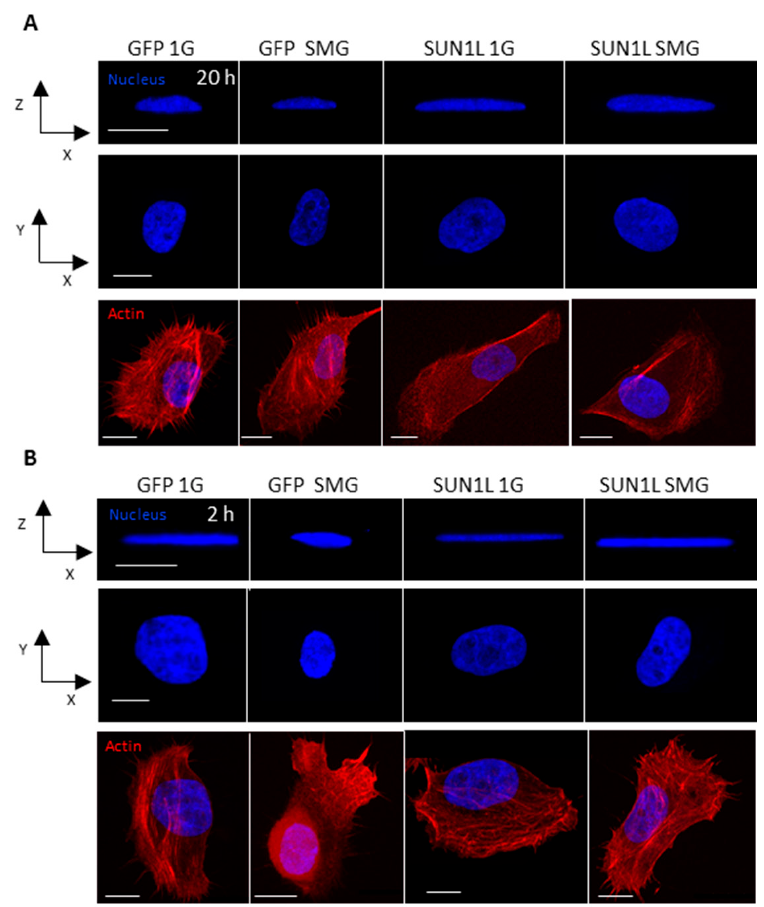
Figure 1. Nuclear shape response to simulated microgravity (SMG) depends on the LINC complex. ( A ) Confocal images show the nuclei (blue) and actin (red) staining (to reveal the cell morphology) of fixed GFP-KDEL (GFP) and SUN1L-KDEL (SUN1L) cells after 20 h in 1G and SMG. Top row shows the x-z view and the bottom rows show the x-y view of the corresponding nuclei and cells. Similarly, ( B ) shows confocal images of the nuclei and actin of fixed GFP-KDEL and SUN1L-KDEL cells in 1G and SMG condition for 2 h. Scale bars are 10 µm. Images are representative of the mean values.